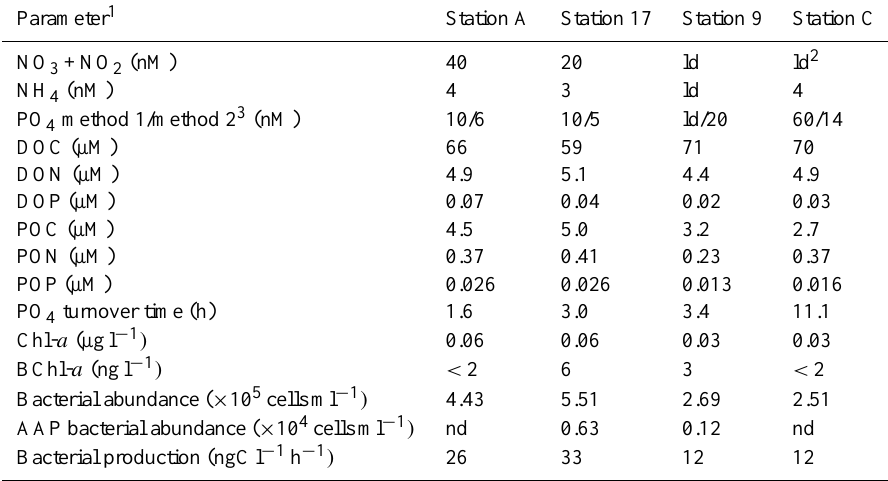
Table 1. Initial chemical conditions and biological parameters prevailing in surface (5m depth) seawater samples before nutrient amend-